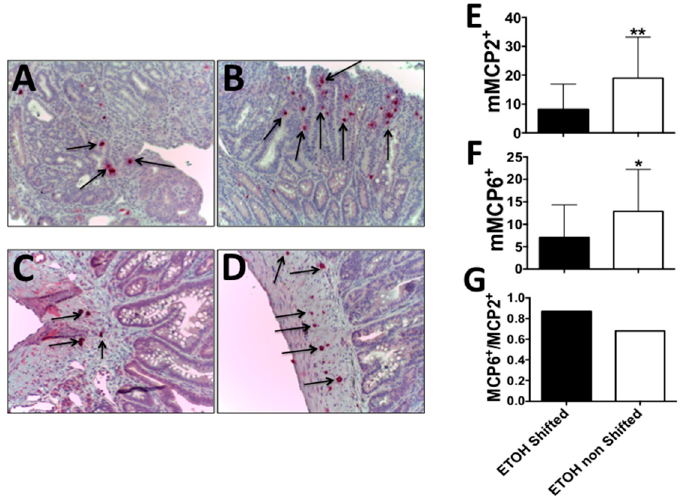
Figure 2. Accelerates tumorigenesis in shifted alcohol-treated mice is associated with a change in the mast cell phenotype towards MCP6 + cells: LD shift increases the ratio of stromal to intra-epithelial mast cells. Fixed and paraffin embedded polyps were stained for mMCP2 or mMCP6, and stained cells were counted using a light microscope. ( A ) Intraepithelial mMCP2 + mast cells in LD shifted + ethanol mice; ( B ) Same in ethanol non-shifted mice; ( C ) Stromal mMCP6 + mast cells in LD shifted + ethanol mice; ( D ) Same in ethanol non-shifted mice; Black arrows point to mast cells; ( E ) Mean values of mast cell counts in panels A + B; n = 24, n = 25 fields, respectively at 200× magnification, (** p = 0.003); ( F ) Mean values of mast cell counts in panels C + D; n = 28, n = 15 fields, respectively, at 200× magnification, (* p = 0.003); ( G ) Ratio of mMCP6 stromal to mMCP2 intraepithelial mast cells.